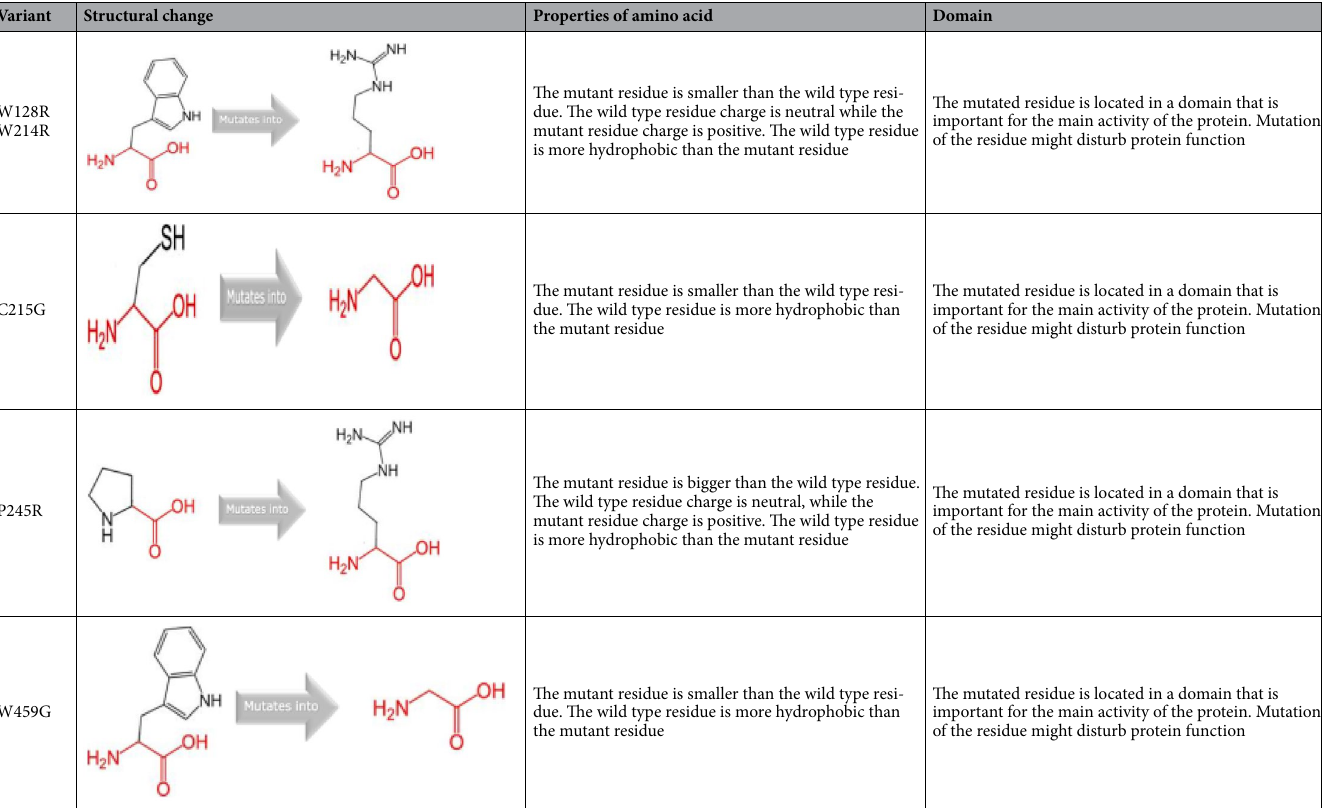
Table 3. Structural impacts of DGAT1 variants due to amino acid